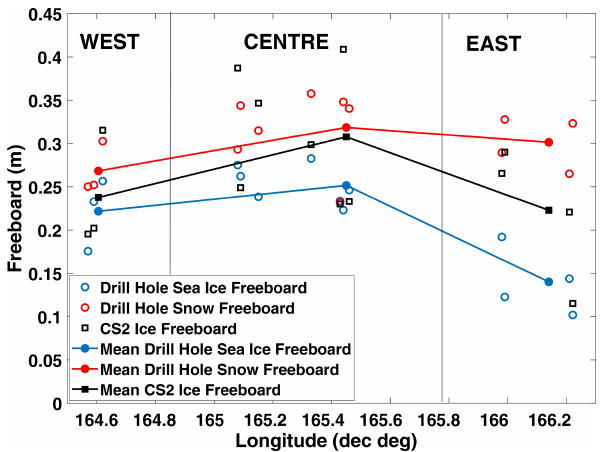
Figure 3. Comparison of all drill-hole-measured sea ice and snow freeboards with CS2 freeboard over first-year fast ice only for the three tracks in the west, seven in the centre and four in the east (refer to Fig. 1 for locations and values given in Table 1). The mean regional values for the tracks in the west, centre and east are shown with a solid line to illustrate the mean freeboard distribution across McMurdo Sound. The longitudes are taken from where each CS2 track crossed latitude 77.7 ◦ S.